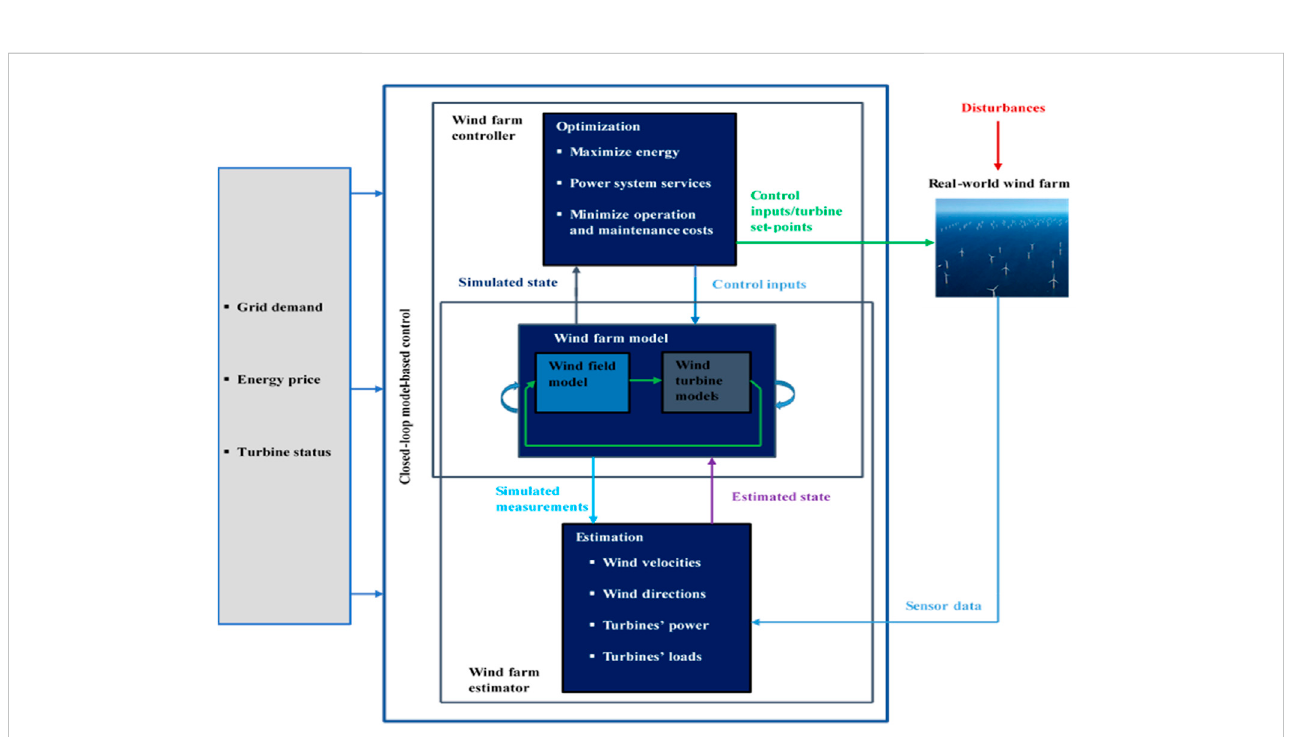
FIGURE 9 Scheme of the model-based closed-loop wind farm control